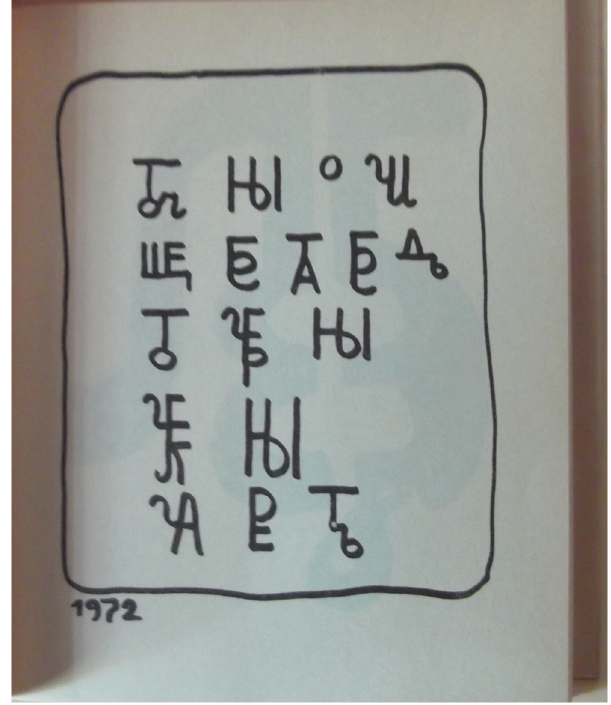
Figure 7. Page from ‘Sobukvy’.